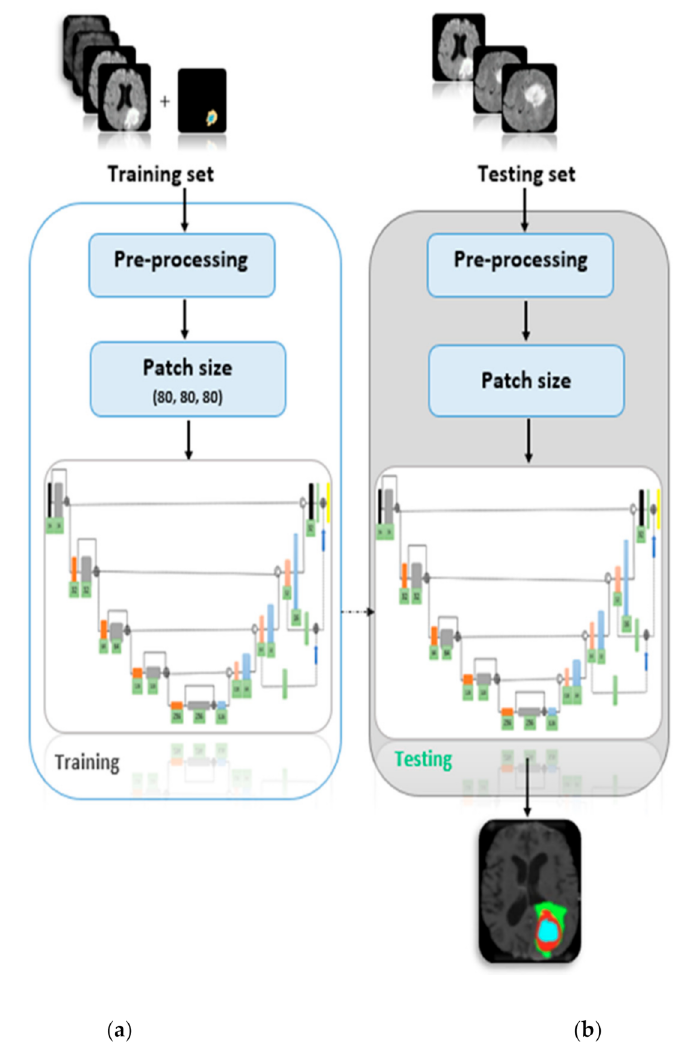
Figure 3. Proposed framework showing the ( a ) training and ( b ) testing